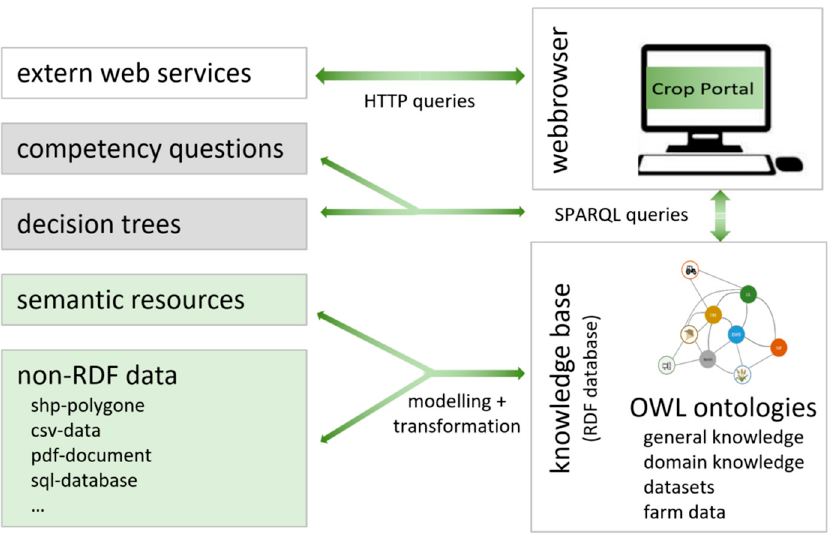
Figure 5. Schematic structure of the decision support system [35,37].